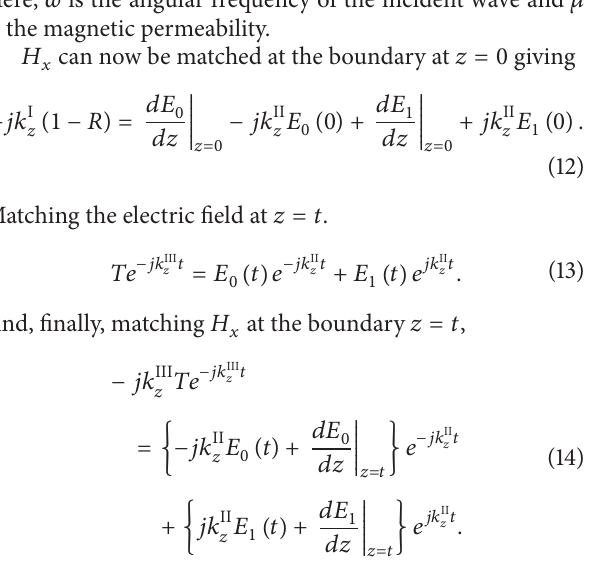
the off-Bragg parameter 𝜙 is evaluated through the following